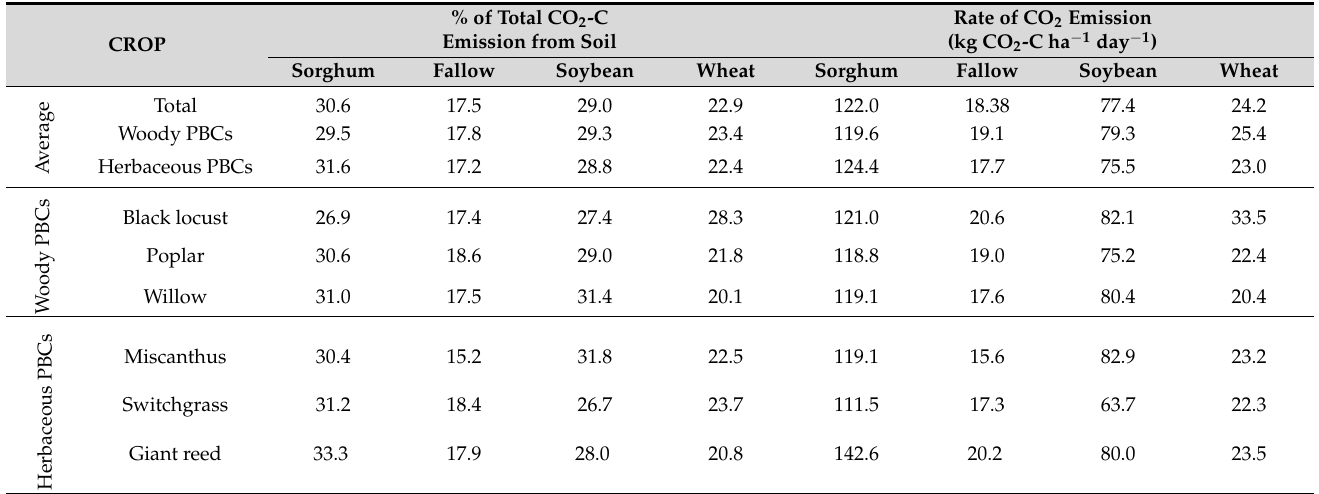
Table 2. Percentage over total C emission and average daily rate (kg C ha − 1 day − 1 ) of C emission as calculated from ECOSSE simulations for each annual crop cultivated after the reversion of perennial biomass crops.